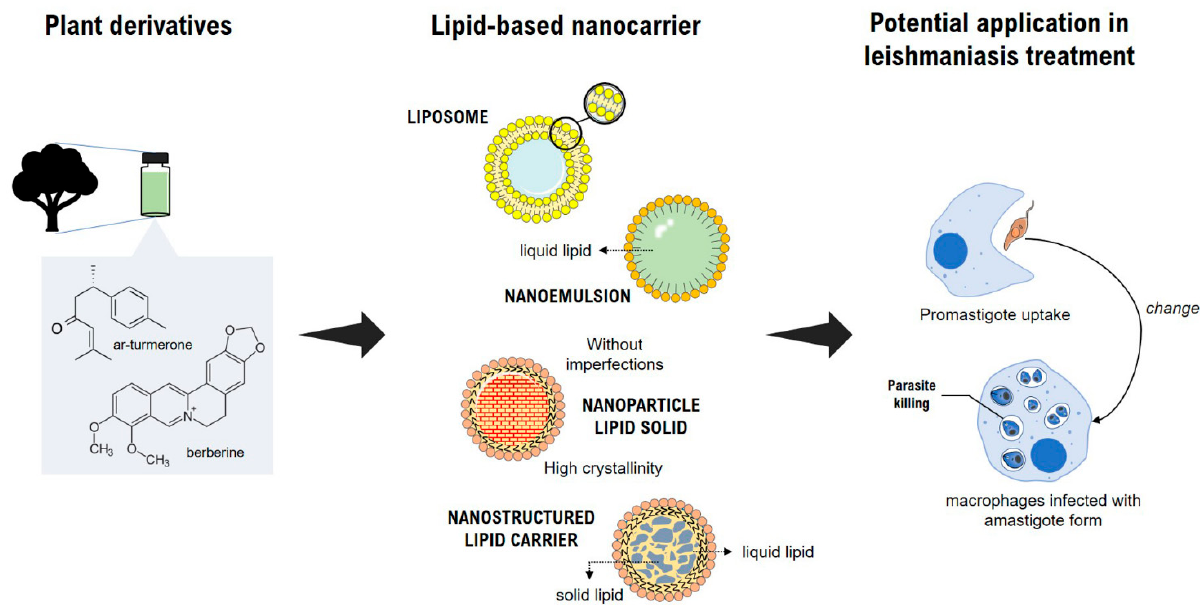
Figure 3. Schematic illustration of plant-based lipid nanocarriers used as potential anti-leishmania